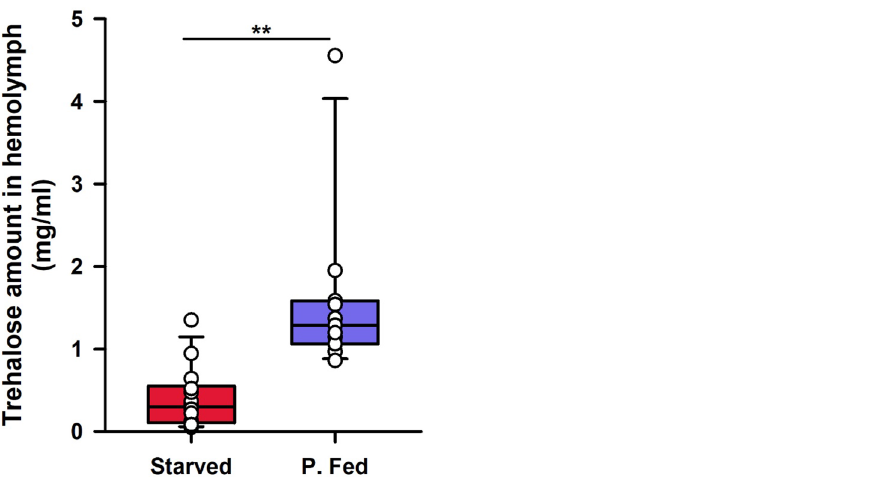
Figure 2. Energy budget of starved (‘Starved’) and partially fed (‘P. Fed’) bees before AKH treatment. Trehalose contents (mg) in hemolymph samples (ml) obtained from starved and fed bees before AKH treatment. The figure shows the median (horizontal line) and the 10th, 25th, 75th and 90th percentiles as vertical boxes with error bars and the corresponding overlaid scatter plots. Sugar levels were quantified using a colorimetric kit for trehalose (see text for details). **P <